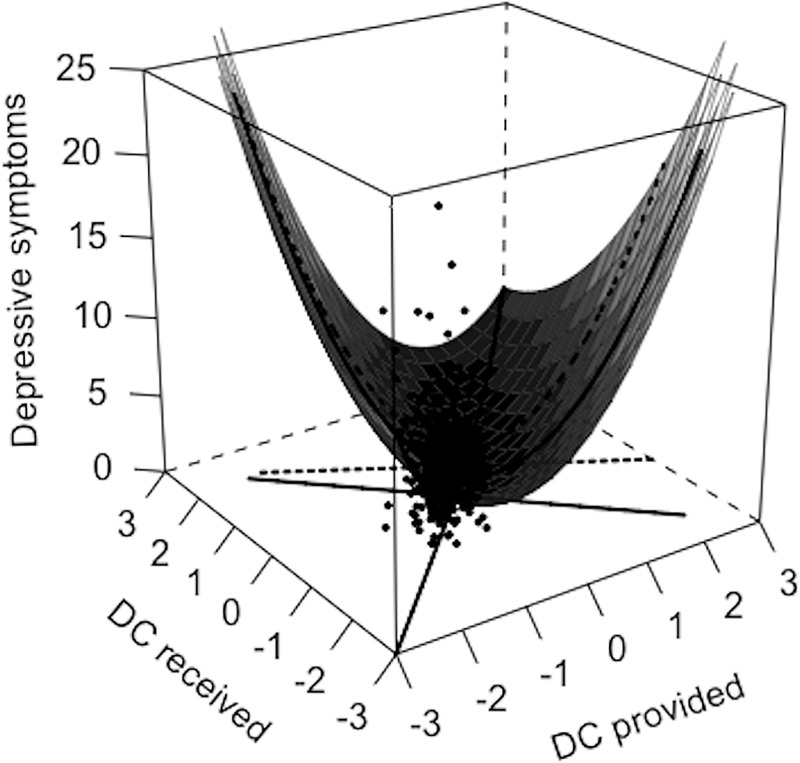
Regressions of women’s depressive symptoms on women’s perceived equity.Note. DC = dyadic coping. Significant curvilinear association between women’s equity and women’s depressive symptoms (actor effect) as visible by lower depressive symptoms along the line of equity (front to back corner) where provided and received dyadic coping are perceived to be the same. Linear associations were not significant as visible by higher depressive symptoms in either direction of inequity, i.e., higher depressive symptoms in the case of overbenefit (received > provided DC; left corner) or underbenefit (received < provided DC; right corner).